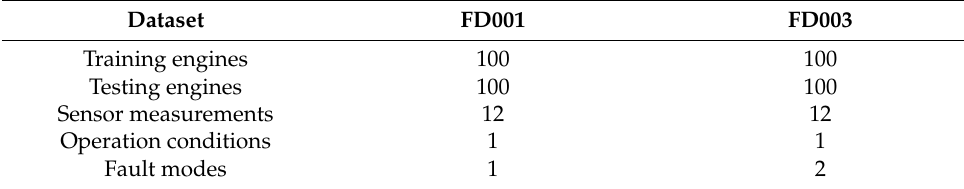
Table 1. Composition of the C-MAPSS dataset.